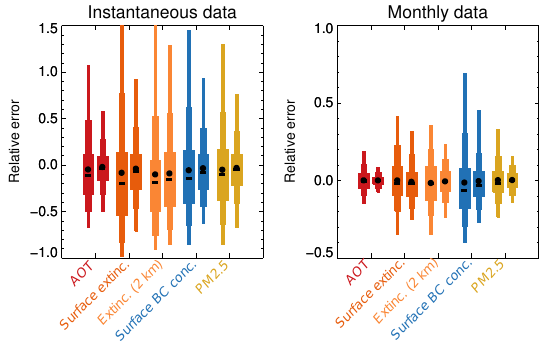
Figure 6. Relative spatial sampling errors (for either instantaneous or monthly data; note the different vertical axes) over the W. Europe region as calculated by WRF-Chem MADE (left bar) and EMEP (right bar) in May 2008. Further explanation in Sect.